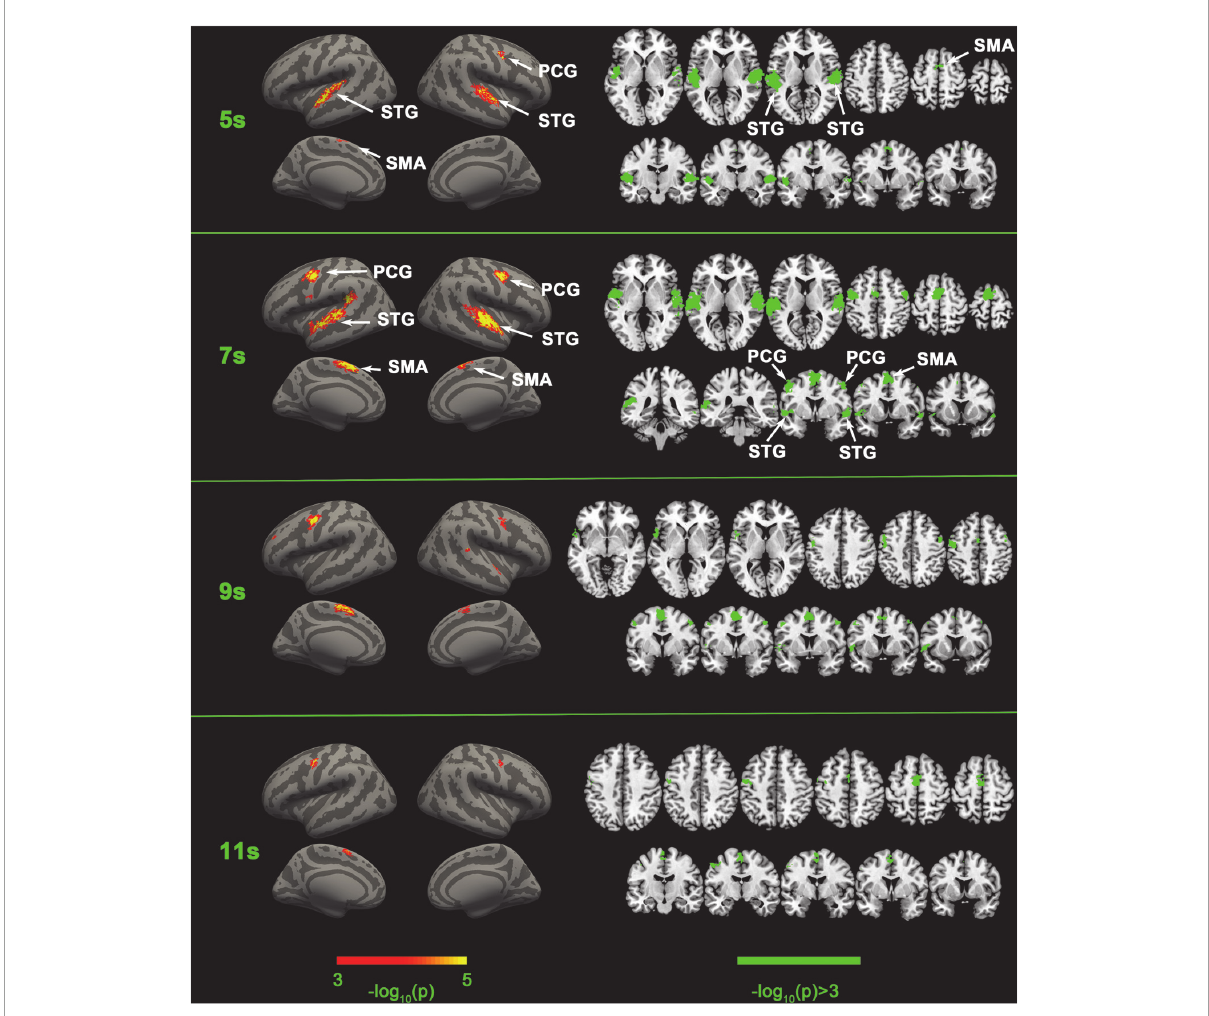
FIGURE3 Comparison of SC-MVPA and the traditional volume space-based MVPA method. The significance of the classification of the five categories of SC-MVPA is shown in the left part, and traditional MVPA is shown in the right